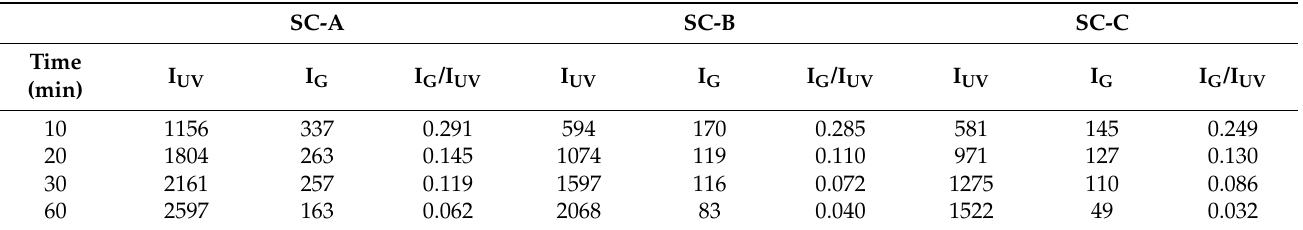
Table 3. Variations in the I UV and I G values and the I G /I UV ratio of the ZnO nanoflower arrays with different synthesis times and substrates. SC-A SC-B